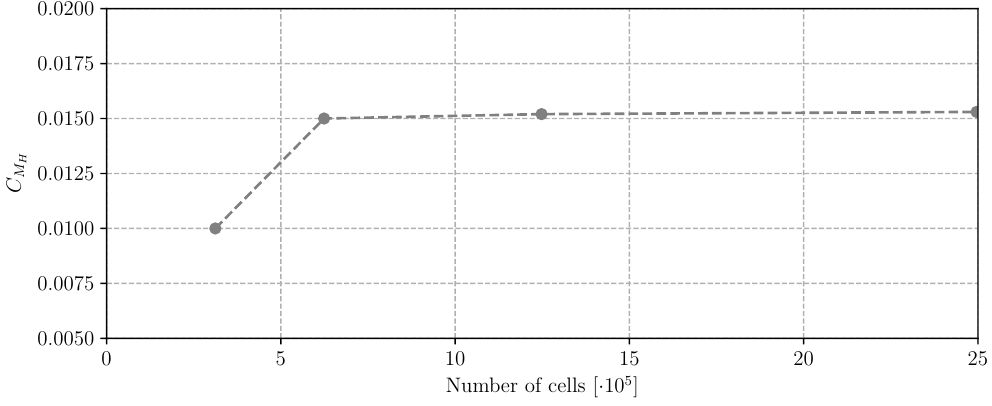
Figure 6. Grid convergence study with regard to the hinge moment coefficient C M airfoil, Ma ∞ = 0.8, Re = 20.7